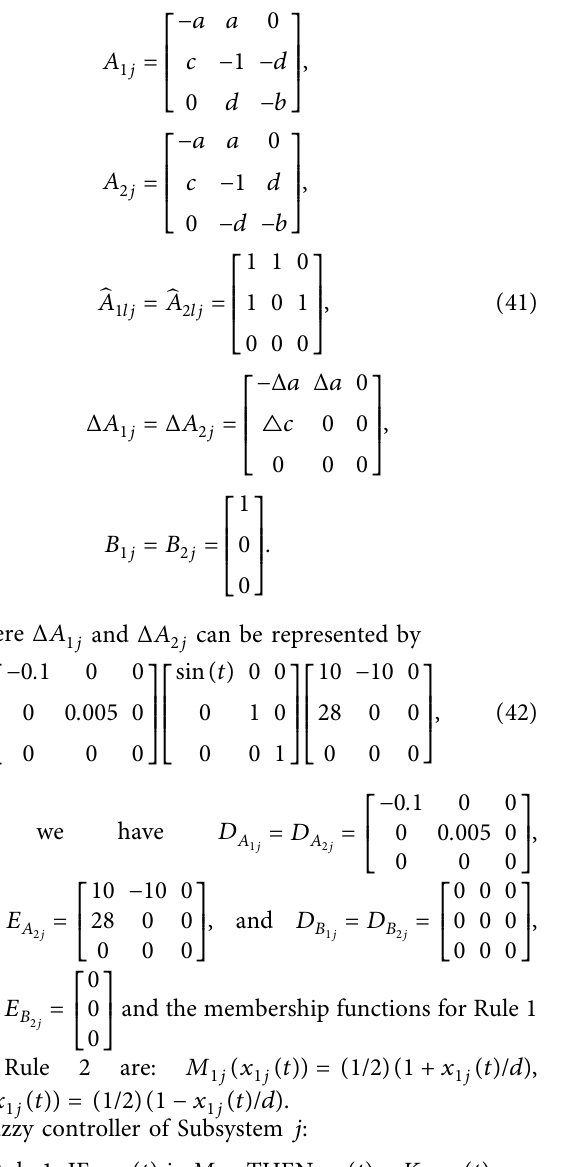
( t ) of the fractional order inter- 1